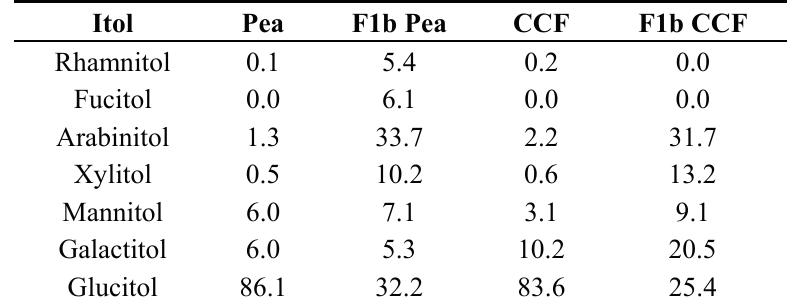
Table 1. Molar ratio of itols identified in JDPP and CCF, and in the corresponding fractions isolated by chromatography (50–120